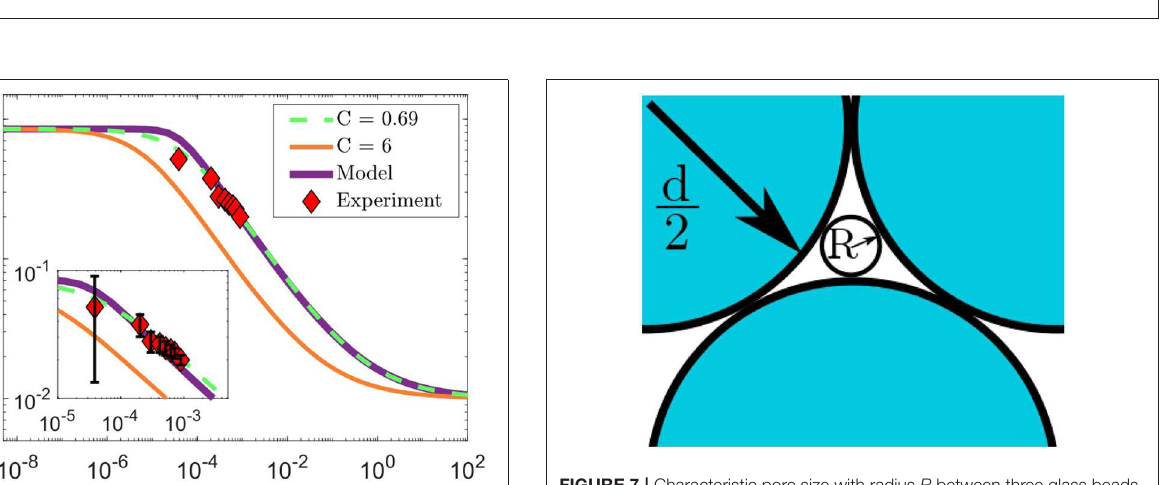
γ ( r )), including the viscosity of the mean shear rate and the mean viscosity for a mean velocity ˙